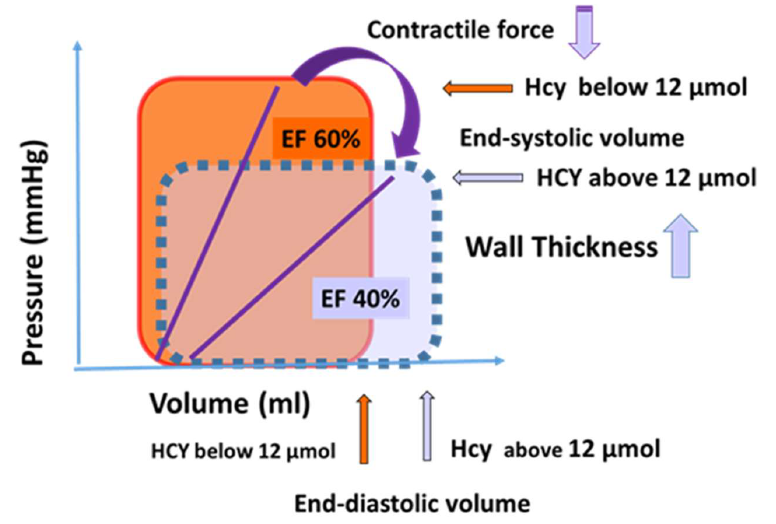
Figure 6. On the basis of our findings, we developed hypothetical cardiac cycles indicating the differences in the cardiac function of the two groups of patients with lower or higher levels of